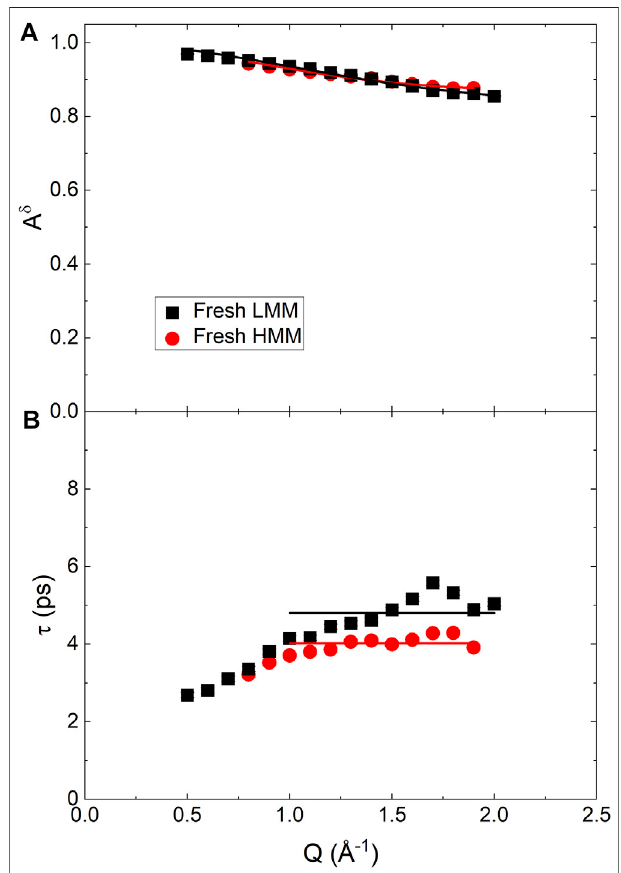
FIGURE 8 | Q dependence of the best fi tting parameters obtained from theQENSspectraoffreshlowandhighmolecularmasspyrolyticligninfraction using Eq. 20 , with β (cid:2) 1. (A) Continuous lines are the fi tting according to Eq. 21 . (B) Straight lines indicate the expected plateau value of τ for Q ≥ 1 Å − 1